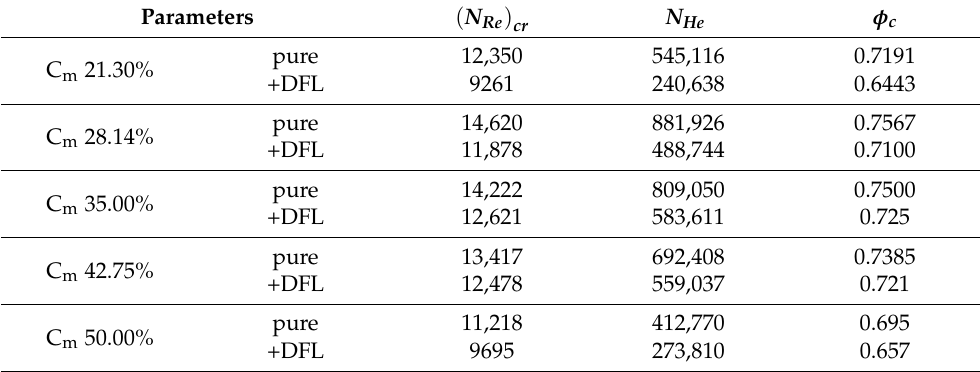
Table 3. Parameters at the transition from a laminar to turbulent flow regime of tested